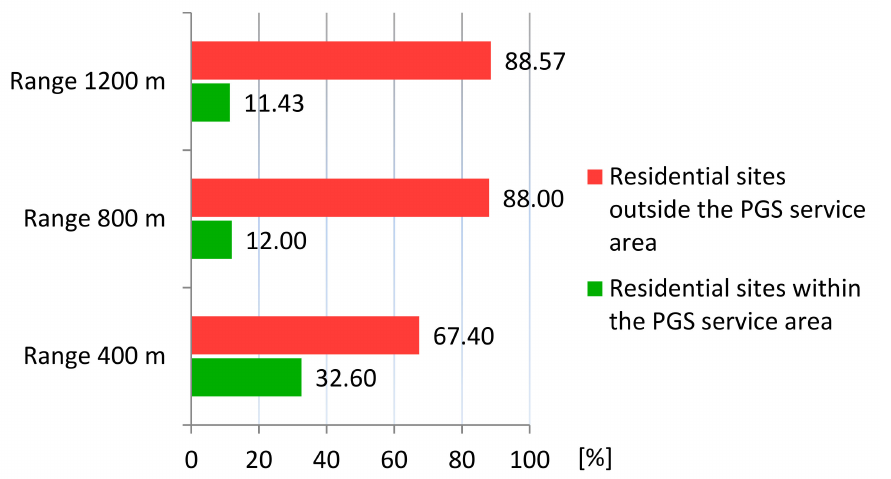
Figure 6. Percentage of residential sites within and outside the service areas of PGS: current state.